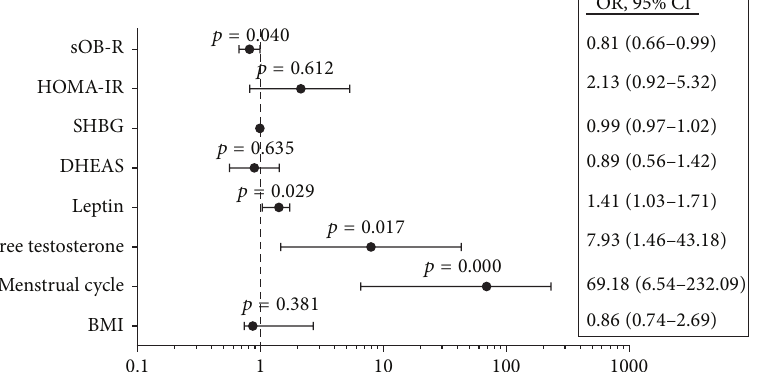
Figure 2: Odds ratio and (95% CI) for PCOS with the individual independent variables were analyzed by the logistic regression analysis. PCOS was diagnosed by NIH criteria. Two-tailed 𝑝 -value is significant at ≤